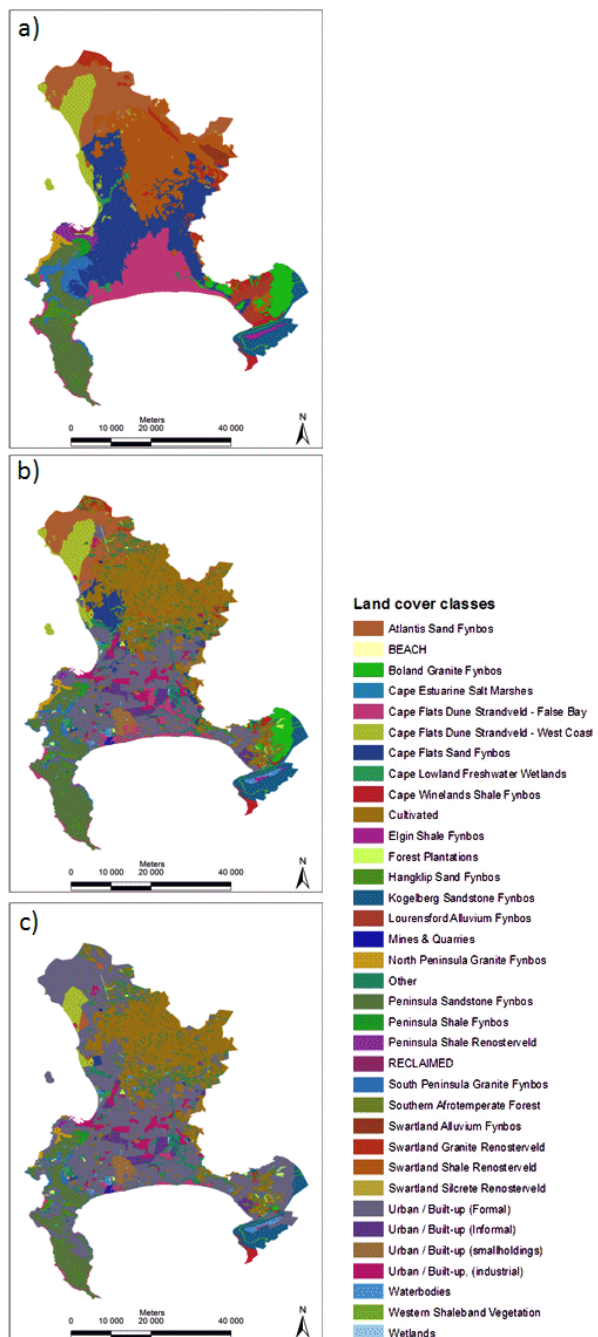
Fig. 1 . Past, potential vegetation cover (a); present, current land-cover (b); and potential future land cover, if all natural remnants, not formally protected, were converted to formal housing (c) for the City of Cape